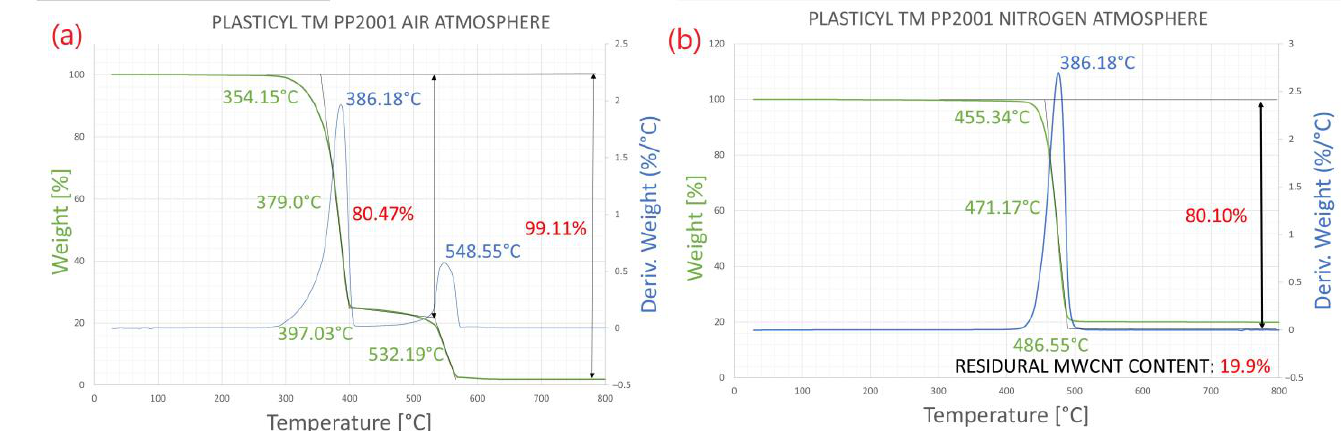
Figure 1. TG curve of PP/MWCNT masterbatch in air ( a ), and nitrogen ( b ) atmosphere.